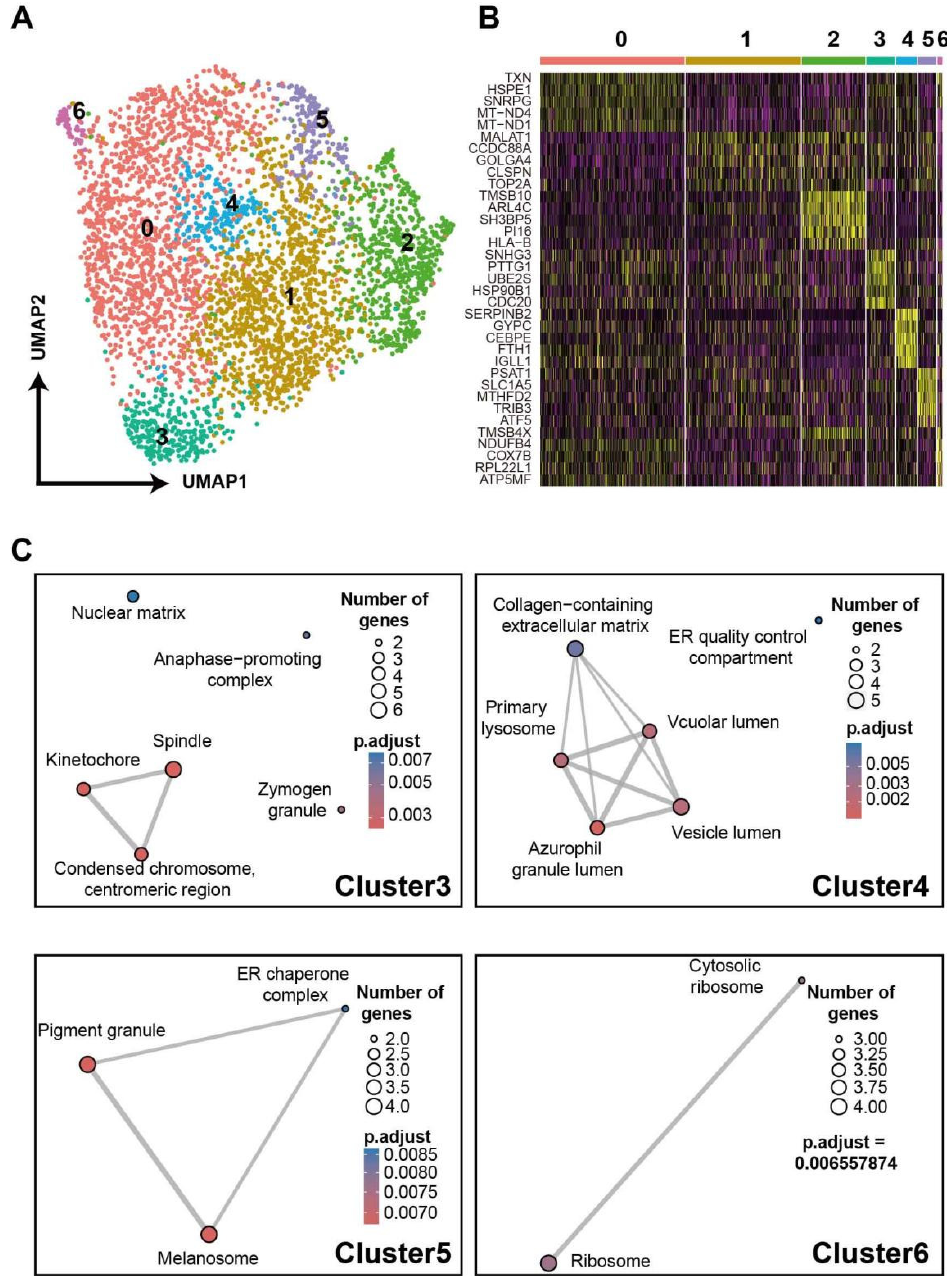
Figure 5. A demo for unveiling TCR ‐ T phenotypes with scRNA ‐ seq data. ( A ) UMAP of TCR ‐ T cells after cell ‐ cycle regression. The numbers 0 to 6 represent seven distinct cell subsets. ( B ) Heatmap of top5 DEGs of each subset. ( C ) GO analyses based on DEGs of each subset.